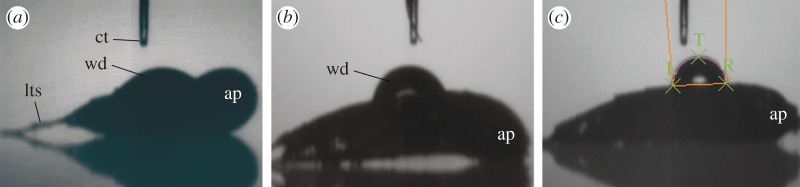
Captured images from the high-speed movies of the water drops on the middle part of Echinoderes komatsui. (a) Intact specimen. (b) Washed specimen. (c) Measurement of the contact angle. ap, anterior part; ct, capillary tip; lts, lateral terminal spine; wd, water drop.